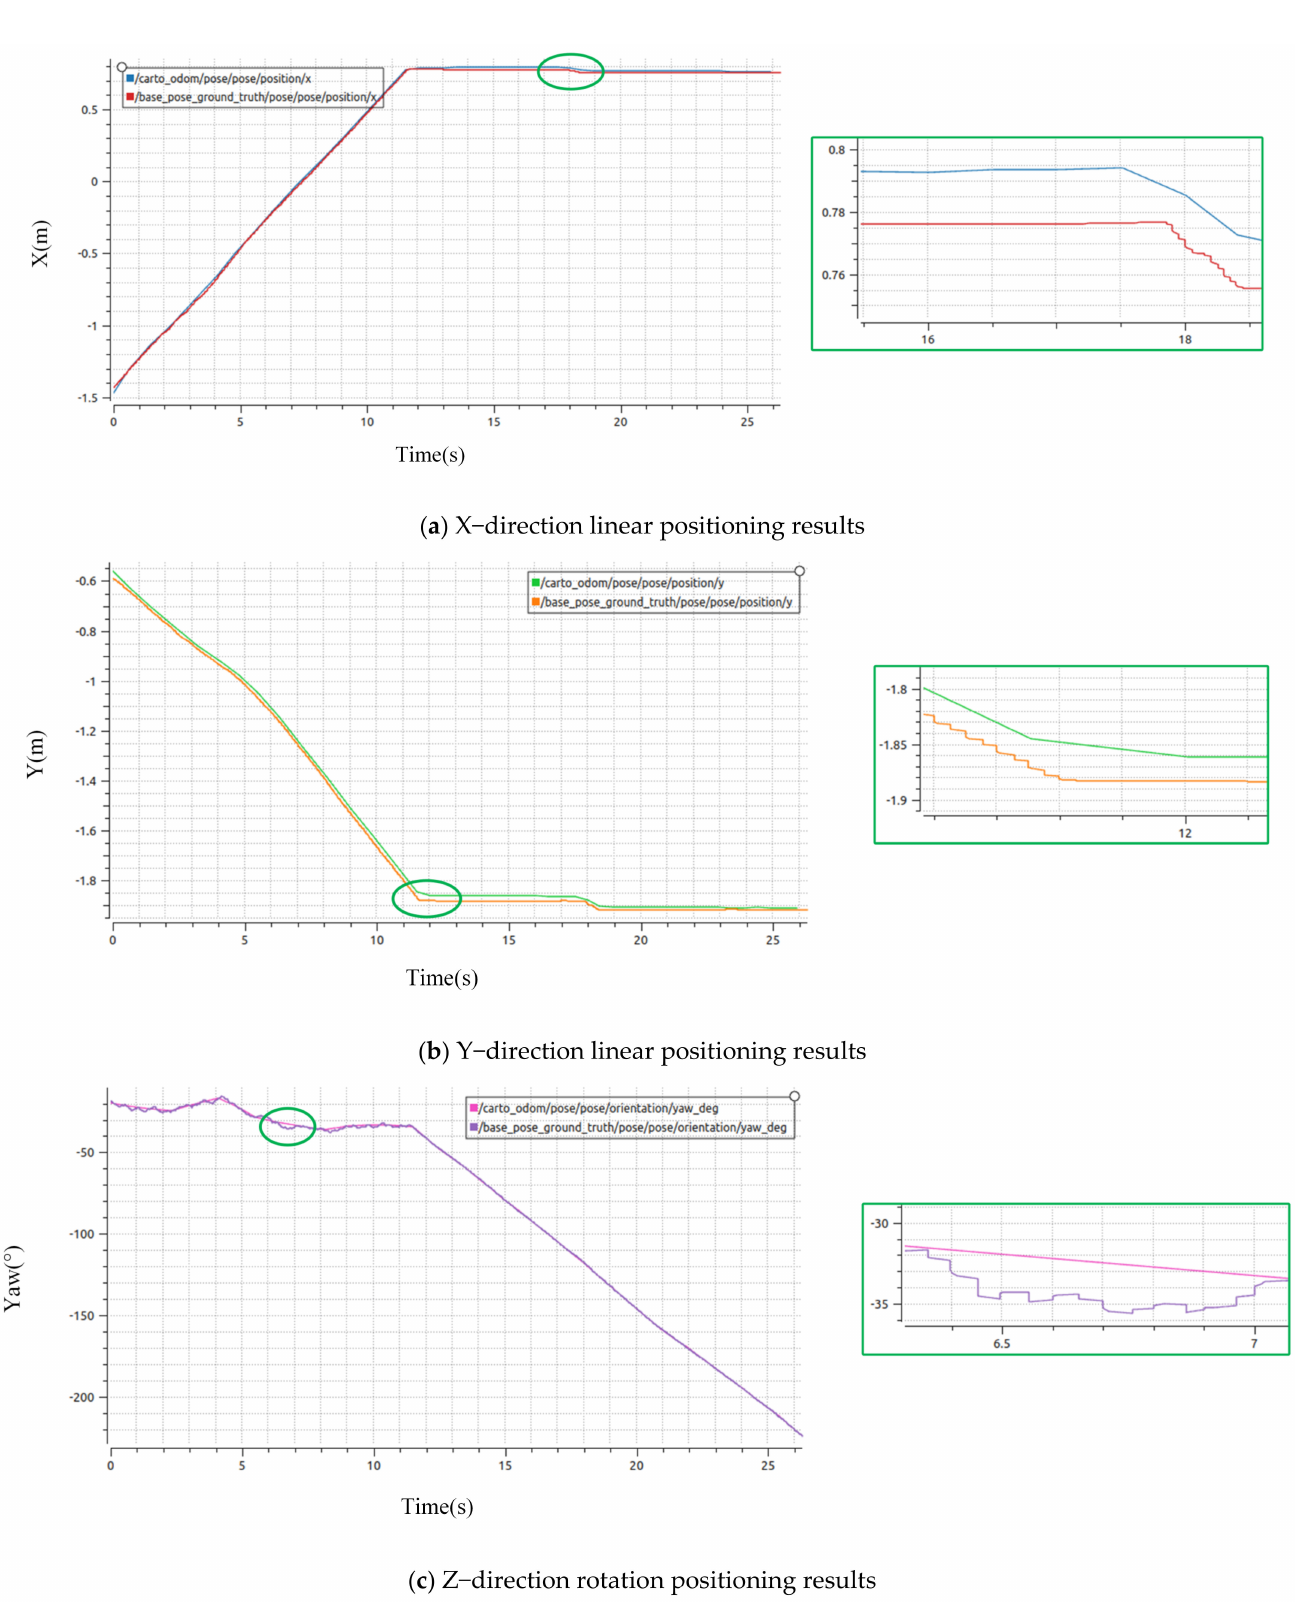
Figure 13. Results of the second group of cartographer simulation positioning